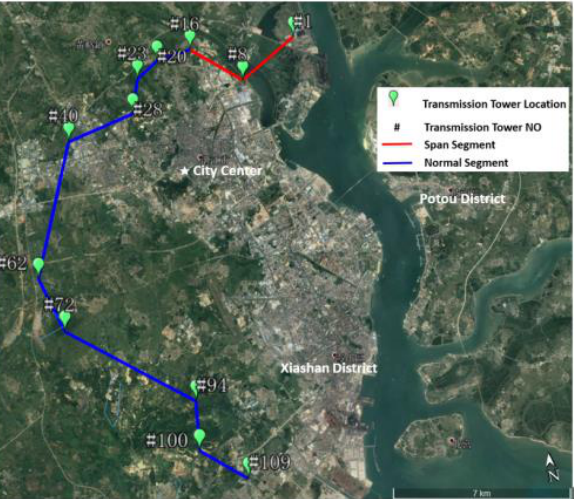
Figure 12. A practical transmission line. * The background image is captured from Google Earth Pro [33].